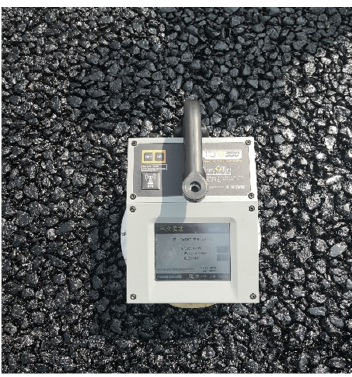
Figure 4. PQI380 used in in-situ test.